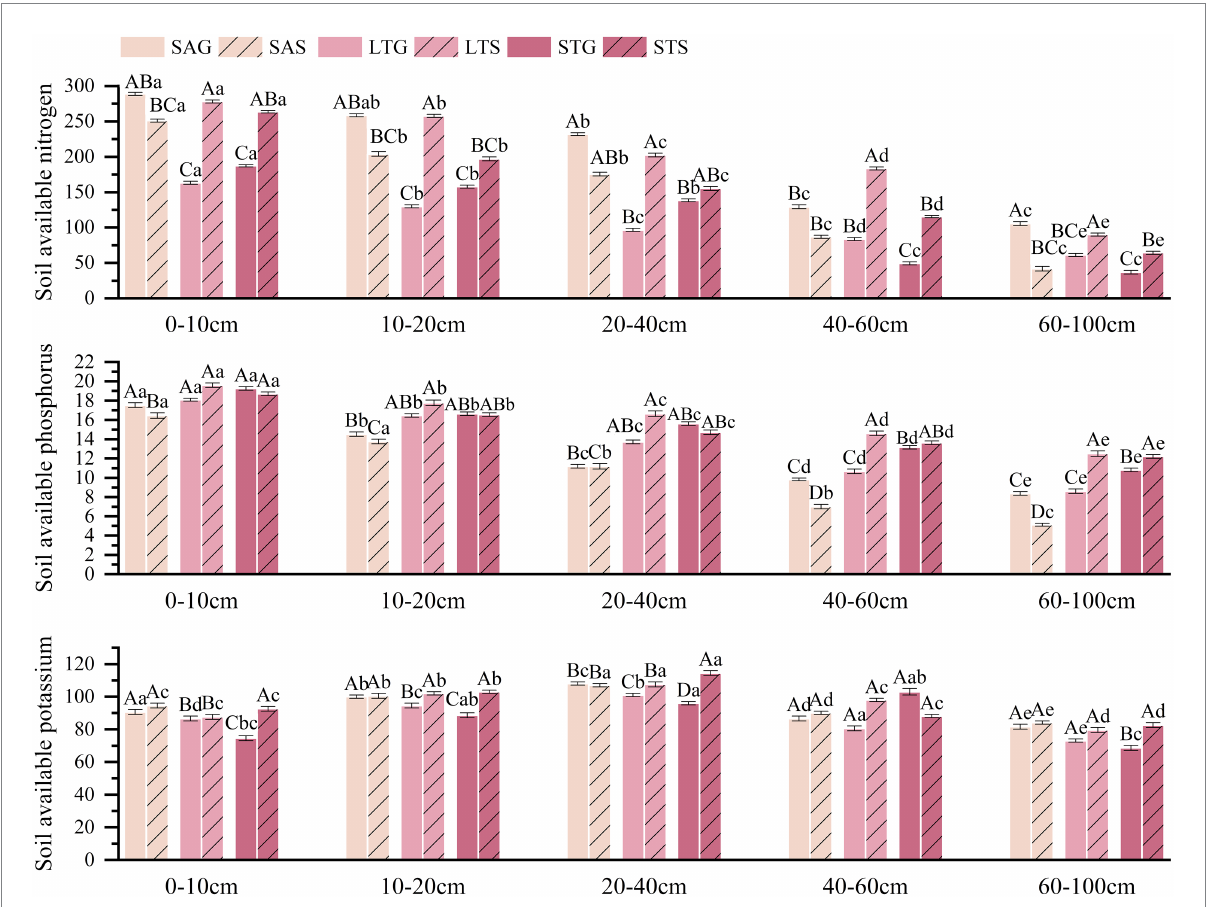
FIGURE 4 Characteristics of soil available nutrients in the 0–100 cm soil profile under three shrub-encroached